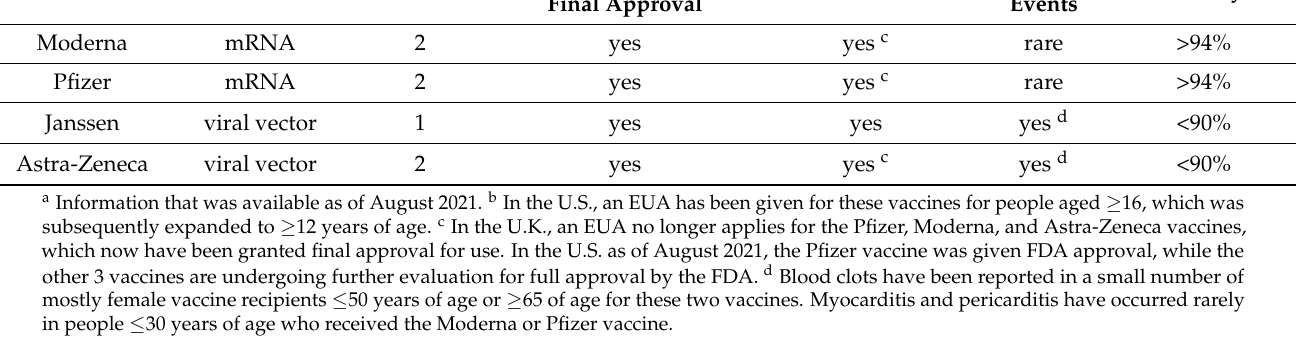
Table 2. Comparison of the key features of the COVID-19 vaccines that are produced by the four leading manufacturers. Vaccine